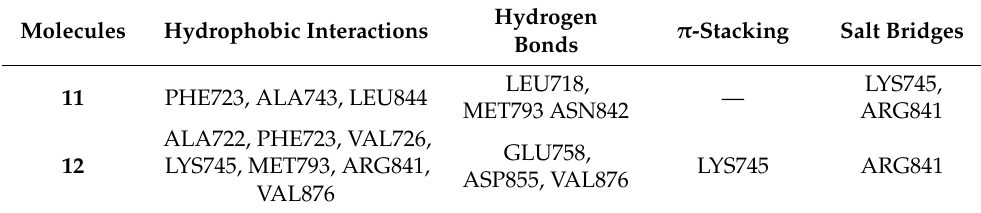
Figure 5. The details of the binding between EGFR and compounds 11 ( A ) and 12 ( B ): the protein is shown as lines; ligand and the key residues are shown as sticks (ligand colors: C cyan, N blue, O red, and H green); hydrogen bonds are shown as black dotted lines; hydrophobic interactions are shown as red dotted lines; π -stacking is shown as gray dotted lines; salt bridges were shown as yellow dotted lines. Table 2. The residues for molecular interaction between EGFR and compounds 4 , 11 and 12